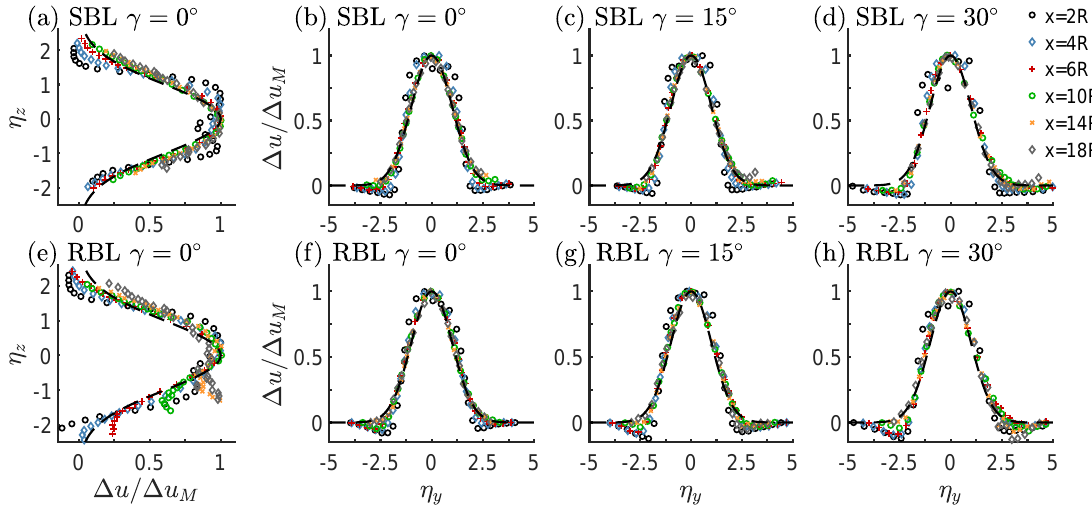
Figure 9. Vertical and lateral profiles of the normalised velocity deficit ∆ u / ∆ u M versus η z and η y in the wake of the model wind turbine immersed in the SBL with ( a )/( b ) γ = 0 ◦ , ( c ) γ = 15 ◦ , ( d ) γ = 30 ◦ and in the RBL with ( e )/( f ) γ = 0 ◦ , ( g ) γ = 15 ◦ , ( h ) γ = 30 ◦ . The black dashed line denotes a Gaussian distribution e − 0.5 η 2 . The legend indicates the downstream